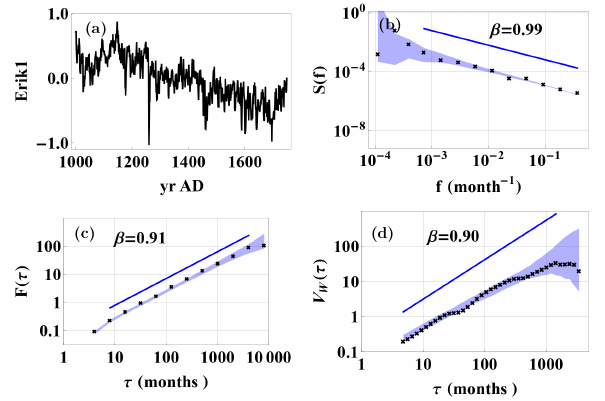
Figure 9. (a) The temperature from the ECHO-G experiment Erik1. (b) PSD, (c) DFA2, and (d) WVA2 applied to the record. The shaded areas are the 95% confidence range for synthetic fGn with β esti- mated by PSD, DFA2 and WVA2. The β -values are estimated from the slopes of the straight lines and the range of scales used for es- timation is indicated by the length and position of these line seg- ments. The estimated β -values are indicated in the